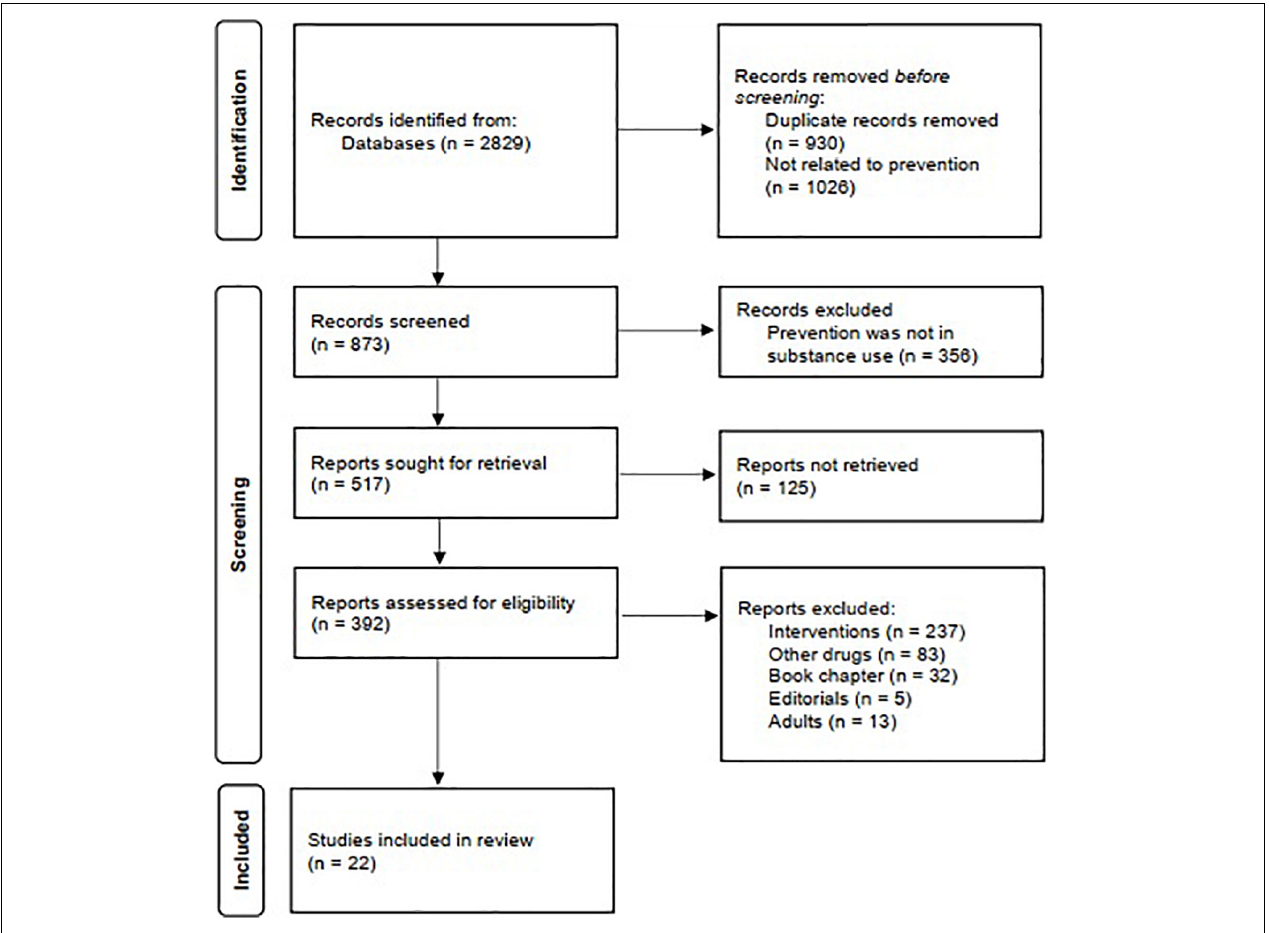
FIGURE 1 | Flow diagram of search and selection of articles according to PRISMA